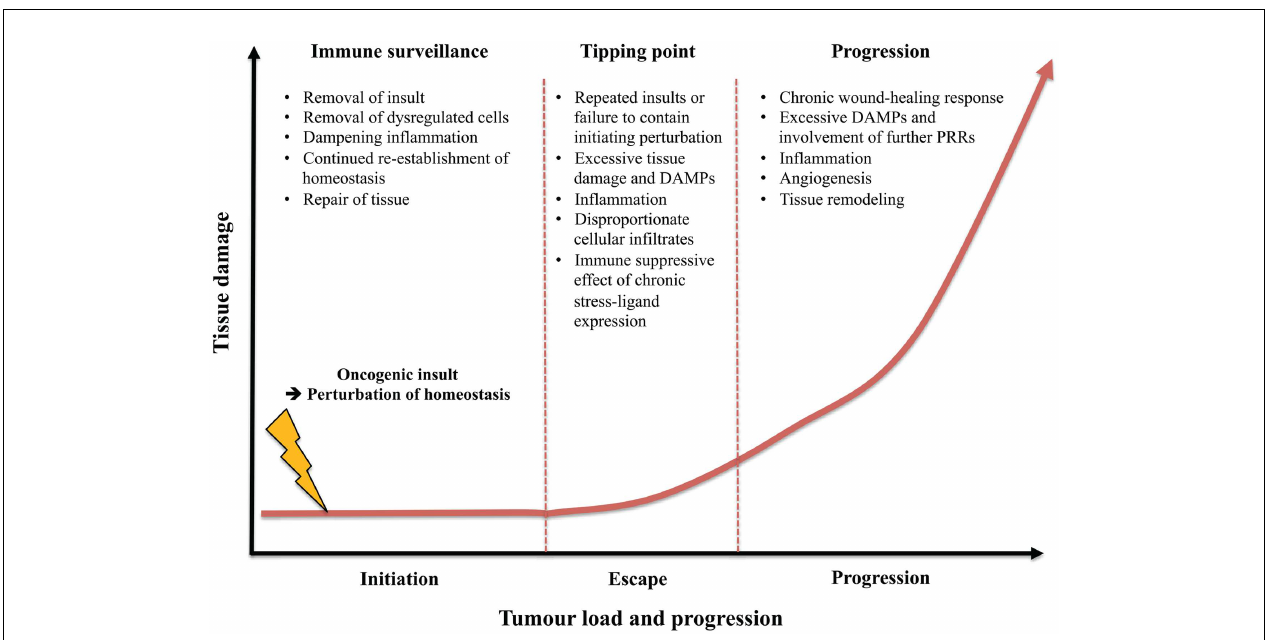
eliminate the initial insult or dysregulated immune surveillance a tipping point may be reached where excessive tissue damage and DAMPs lead to inflammation, disproportionate cellular infiltrates, and escape from immune surveillance and tissue homeostasis. Once a certain level of tissue damage is reached, a perpetual type 2 response may be detrimental to the host by transitioning to aid carcinogenesis by promoting a chronic wound-healing response and fibrosis as well as supporting